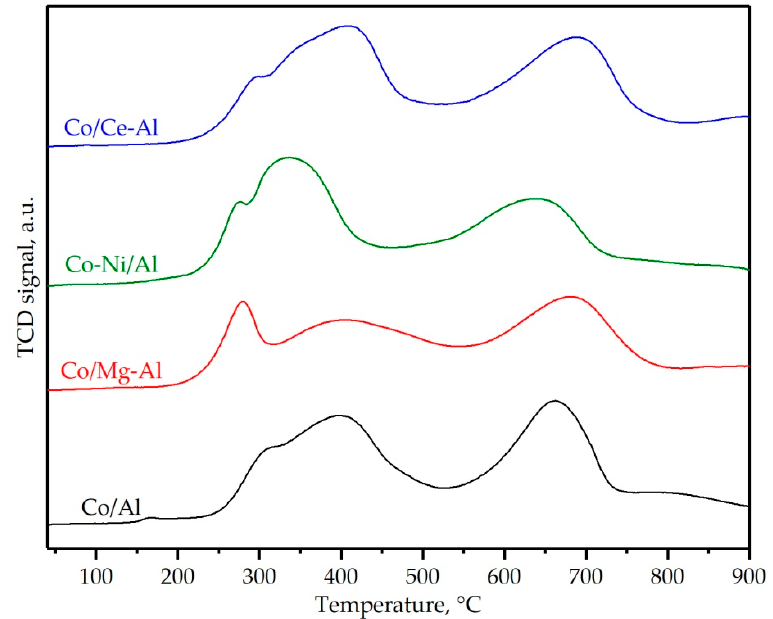
Figure 7. Temperature-programmed reduction with hydrogen (H 2 -TPR) profiles of the supported cobalt catalysts.